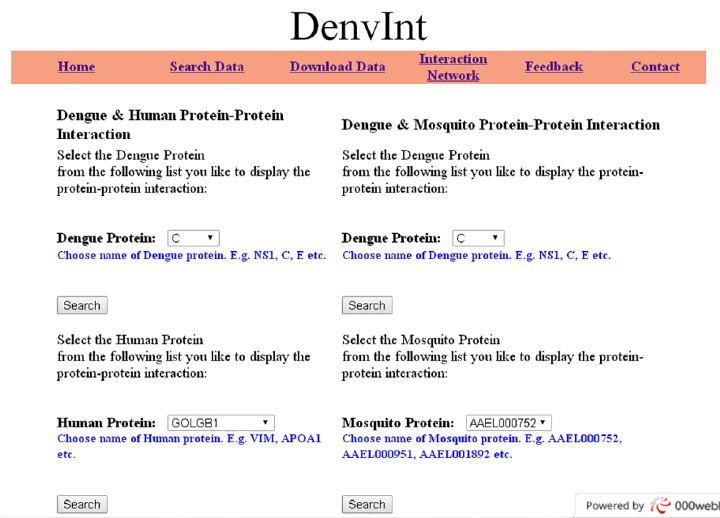
Fig 2. Screenshot of user query interface of DenvInt database. User can retrieve interaction data by selectinga dengueprotein or a host protein from the list.